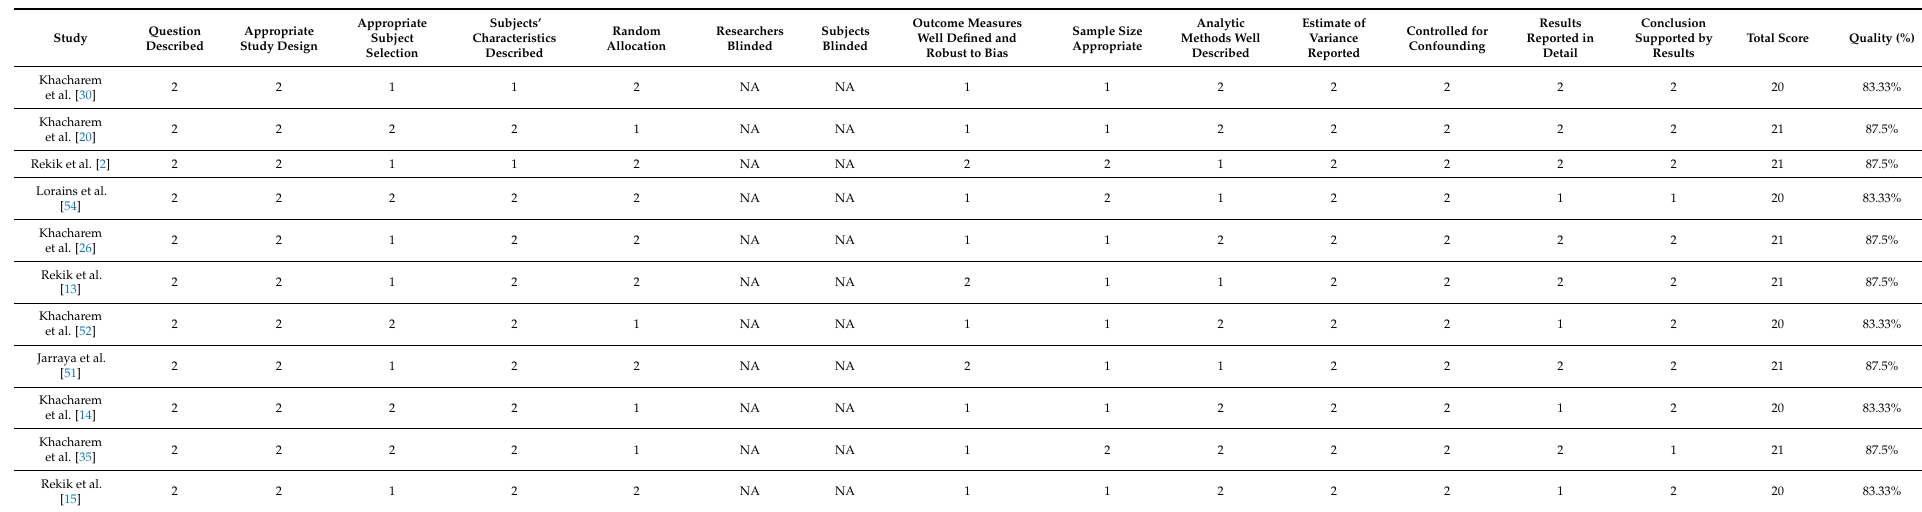
Table 1. Quality appraisal of included